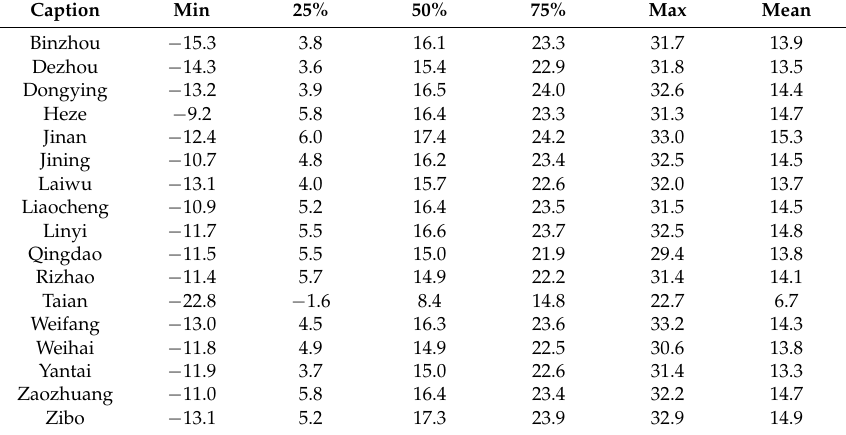
Table A5. Descriptive statistics of the daily mean temperature ( ◦ C) in the 17 cities of the Shandong province (from 1 January 2015 to 31 December 2016).